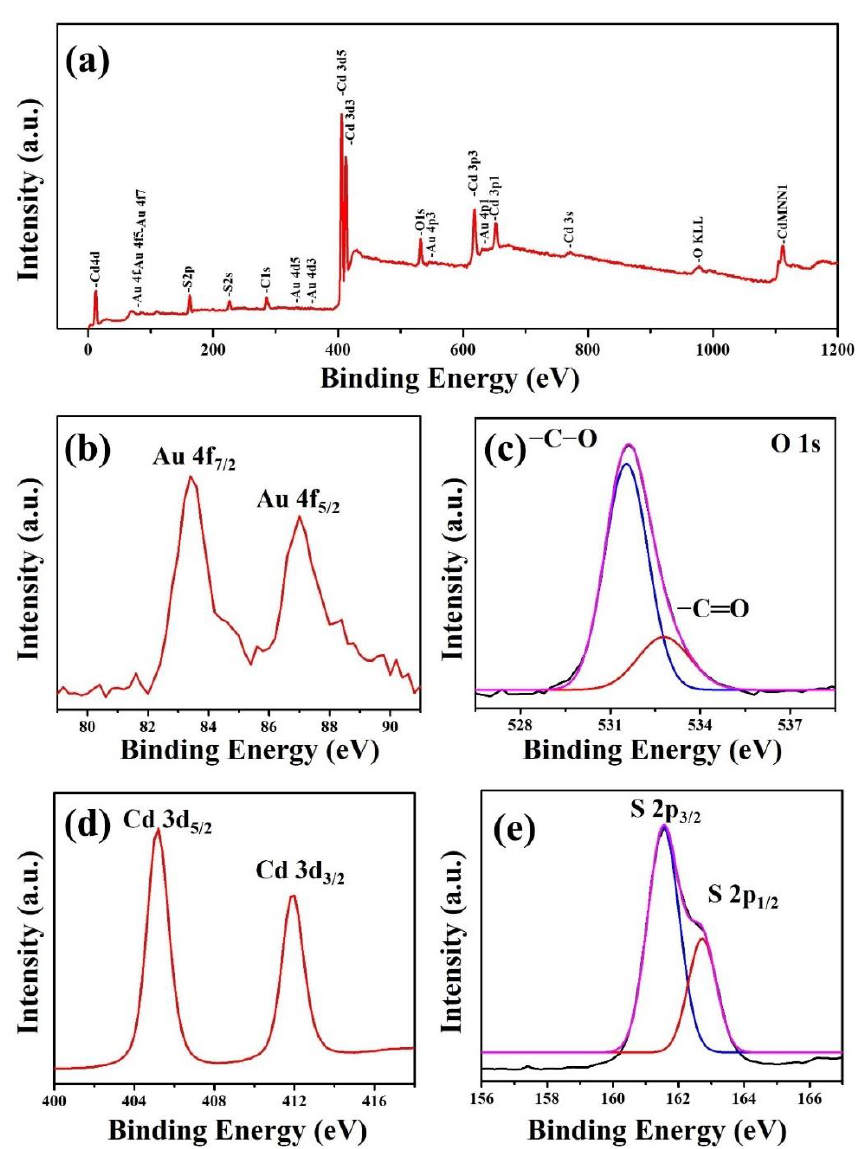
Figure 5. The XPS spectra of Au@CdS nanocomposites: ( a ) survey spectrum, ( b ) Au 4 f, ( c ) O 1 s, ( d ) Cd 3 d, and ( e ) S 2 p.